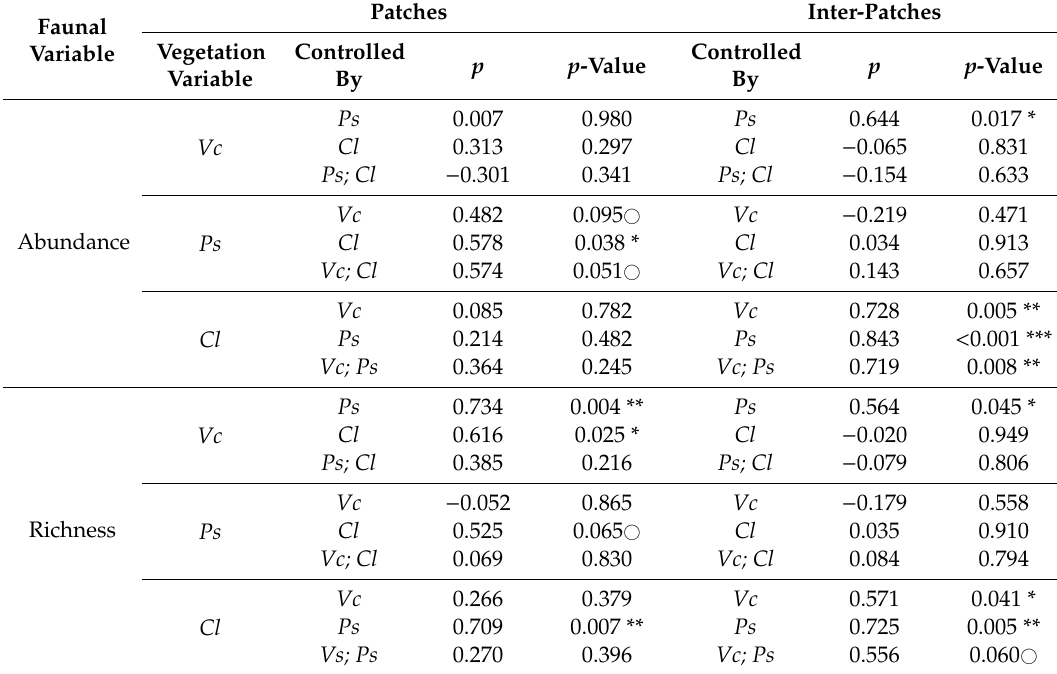
Table 2. Partial correlation coe ffi cients ( p ) and p -values for the relationships between landscape-scale vegetation pattern variables and species richness and abundance of ground arthropods found in vegetation patches and inter-patches. V C : Vegetation cover; P S : Average patch size; Cl : Average closeness between patches (inverse of respective average distance); significant at 5%, 1%, and 0.1%,